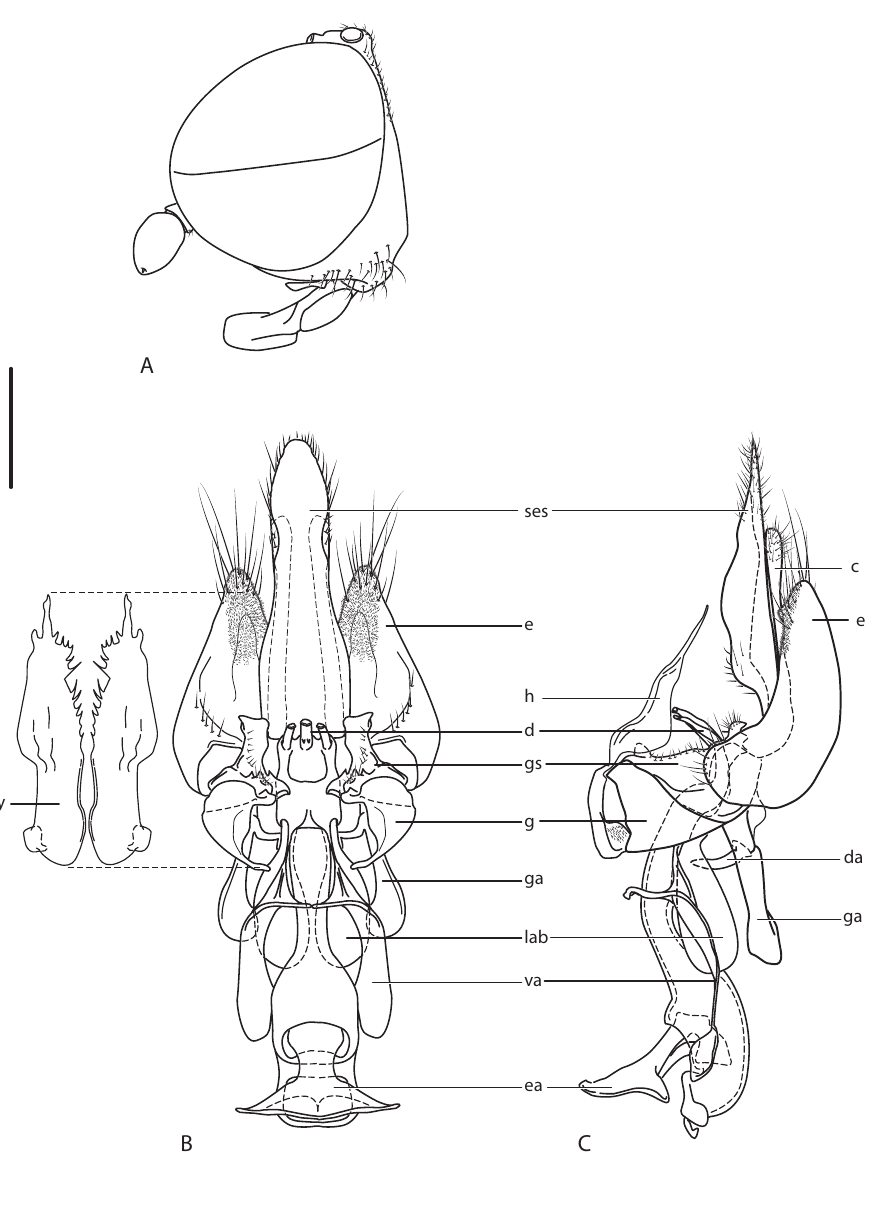
Figure 2. Prepseudatrichia tiger sp. n. A Male head, lateral view. Male genitalia B dorsal view (physi- cally dorsal), hypandrium removed to show internal structures C same lateral view with hypandrium in place. Scale line = 0.25 mm. Abbreviations: c , cercus; d , distiphallus; da , dorsal apodeme of parameral sheath; e , epandrium; ea , ejaculatory apodeme; g , gonocoxite; ga , gonocoxal apodeme; gs , gonostylus; h , hypandrium; ses , subepandrial sclerite; lab , lateral aedeagal bulb; va , ventral apodeme of parameral